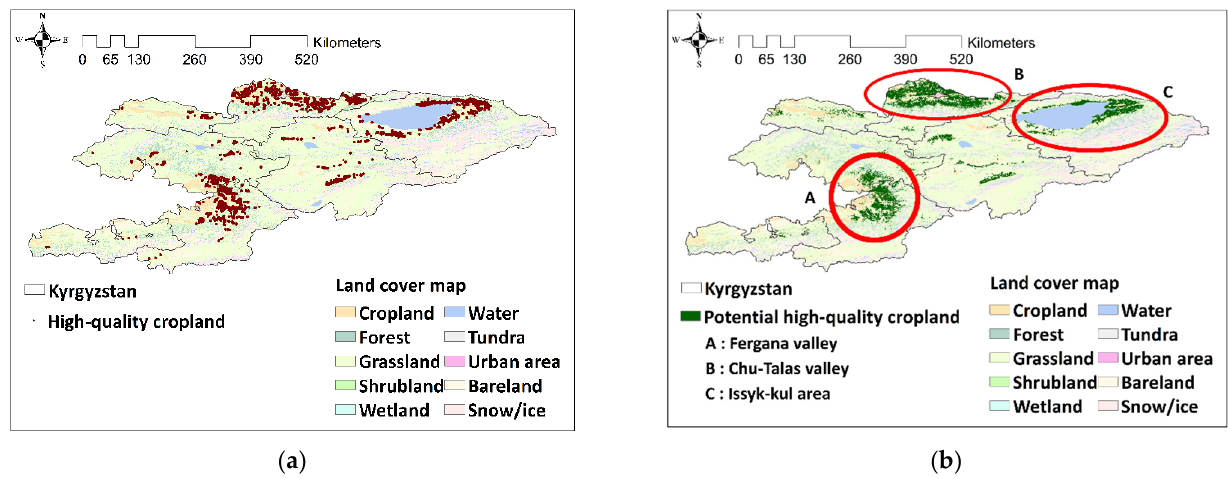
Figure 2. High-quality cropland and potential high-quality cropland: ( a ) High-quality cropland in Kyrgyzstan, serving as training label data for predicting potential high-quality cropland. ( b ) Spatial distribution of potential high-quality croplands under baseline climate conditions throughout the random forest model.